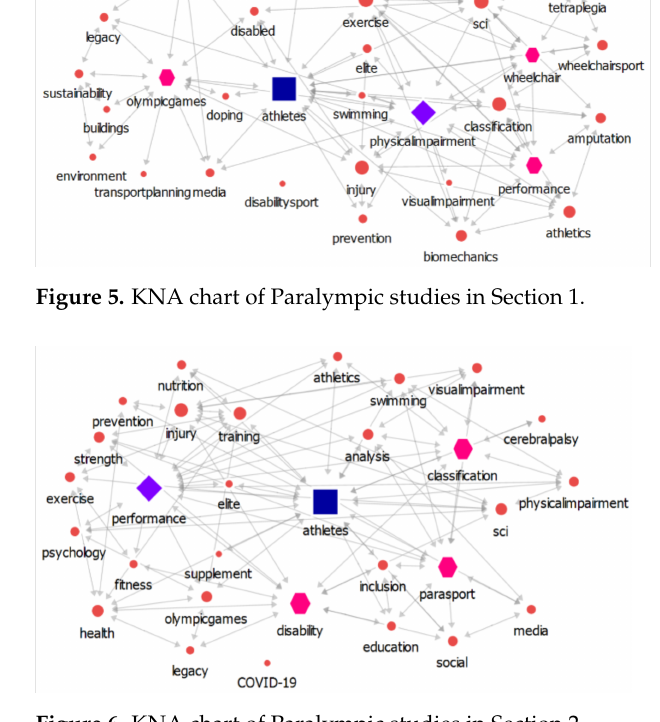
Figure 6. KNA chart of Paralympic studies in Section